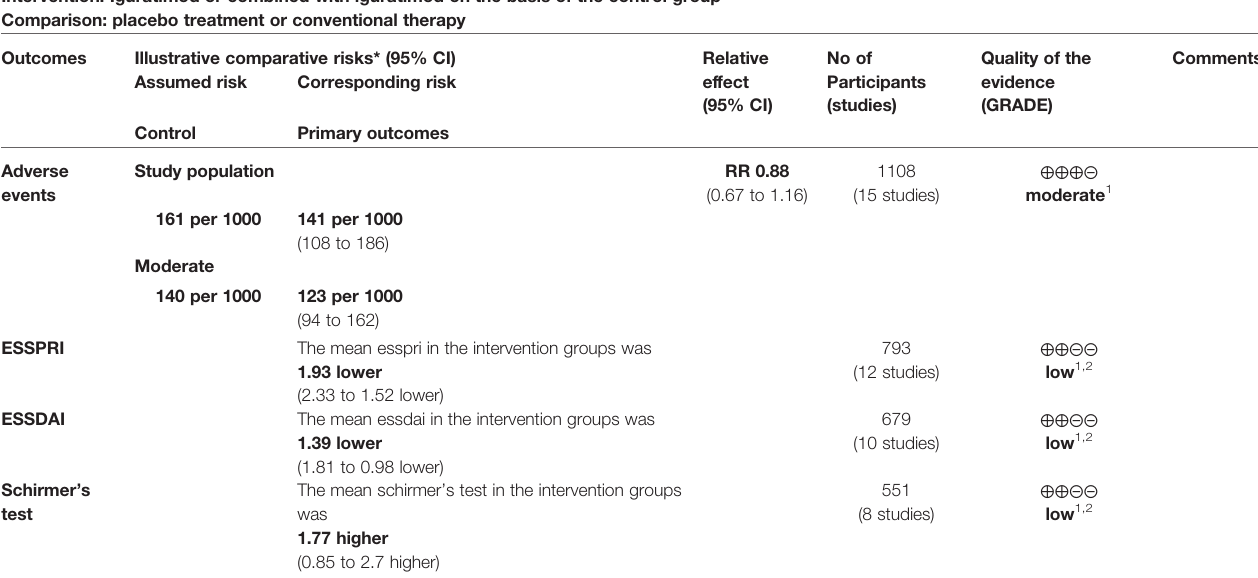
TABLE 3 | Summary of fi ndings for the main comparison. Iguratimod intervention in pSS Patient or population: patients with pSS Intervention: Iguratimod or combined with iguratimod on the basis of the control group Comparison: placebo treatment or conventional therapy